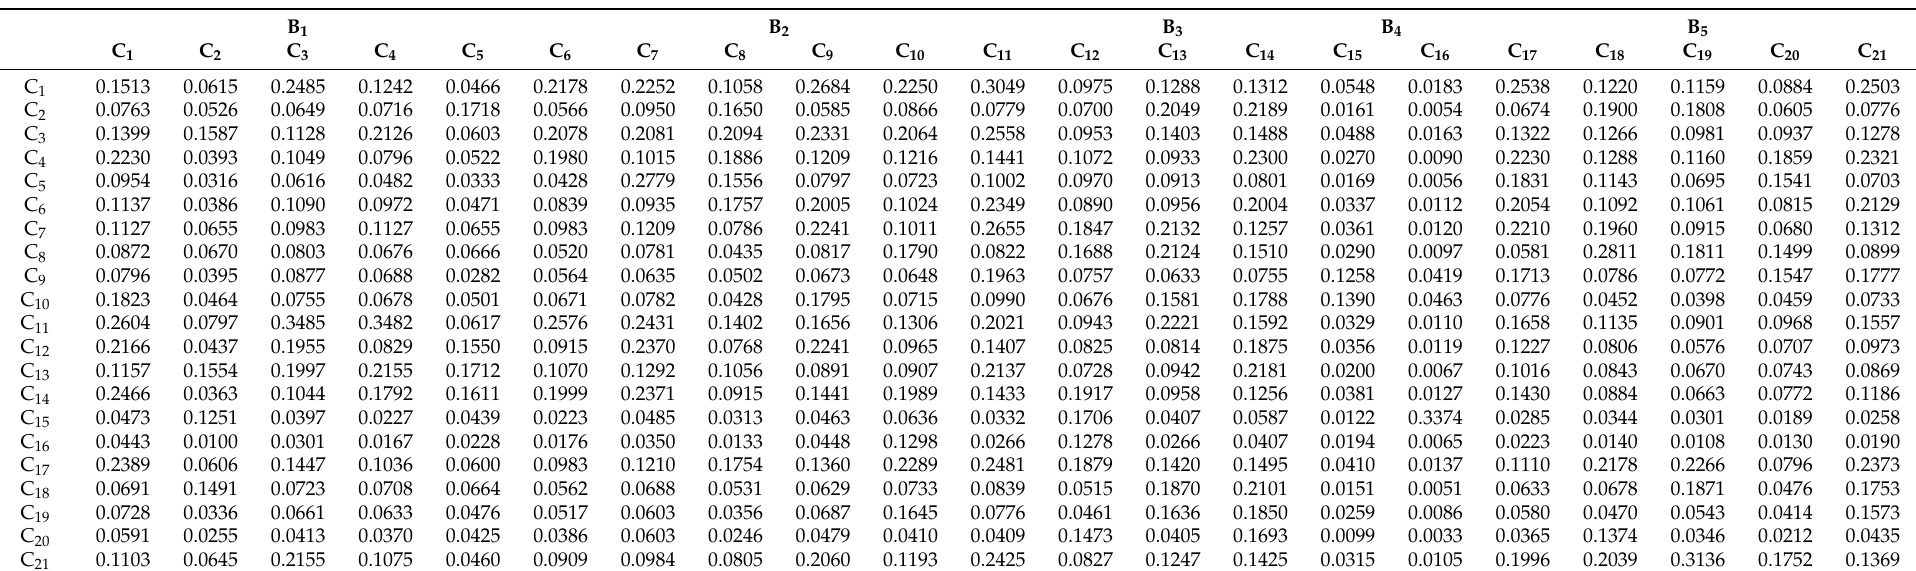
Table A3. The total influence matrix of the